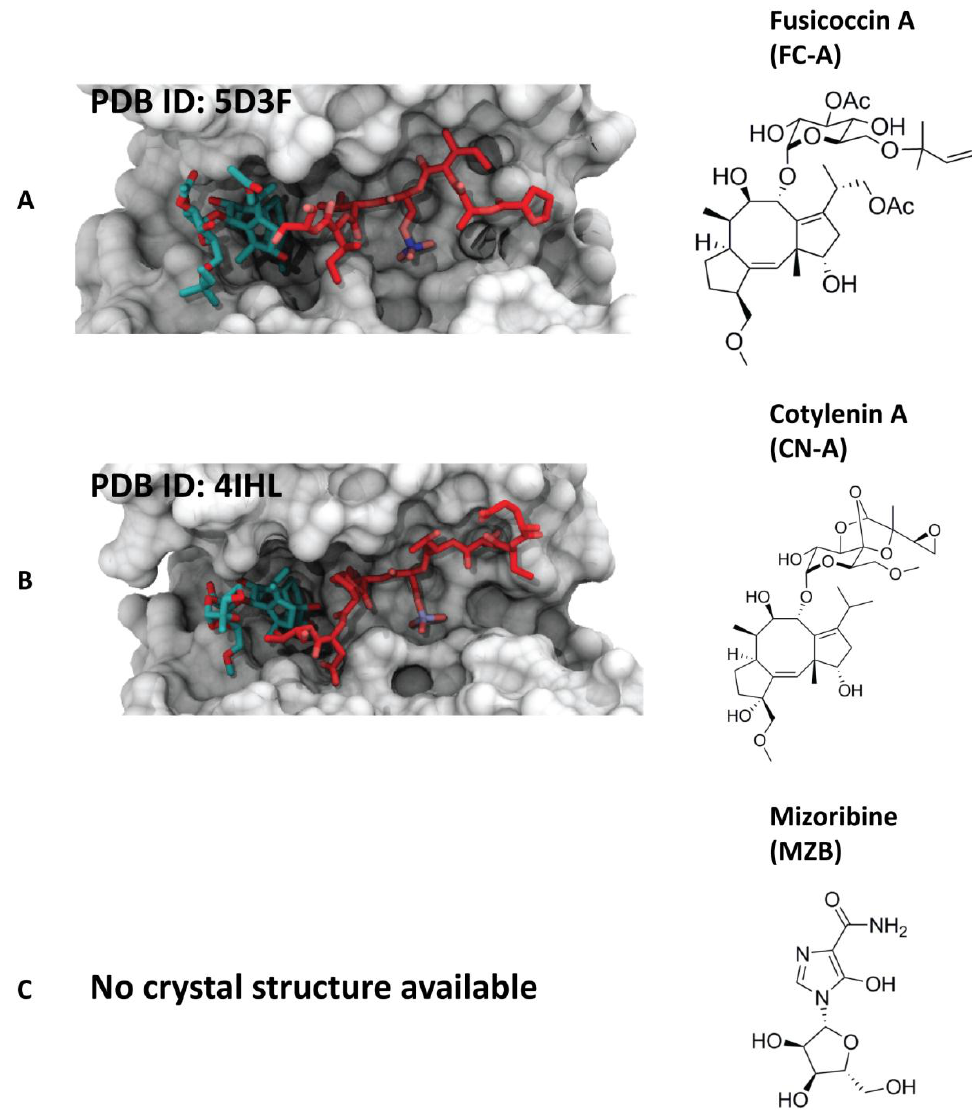
Figure 4. Examples of the different natural 14-3-3 protein–protein interaction (PPI) stabilizers. ( A ) Left side: crystal structure of 14-3-3 ζ (white surface) in complex with peptide cystic fibrosis transmembrane conductance regulator (CFTR) R-domain pS753-pS768 (red sticks) and stabilizer fusicoccin-A (cyan sticks) [35]; right side: chemical structure of fusicoccin-A; ( B ) left side: crystal structure of 14-3-3 ζ (white surface) in complex with a dephosphorylated C-RAF peptide (red sticks) and cotylenin A (cyan sticks) [43]; right side: chemical structure of cotylenin A; ( C ) right side: chemical structure of